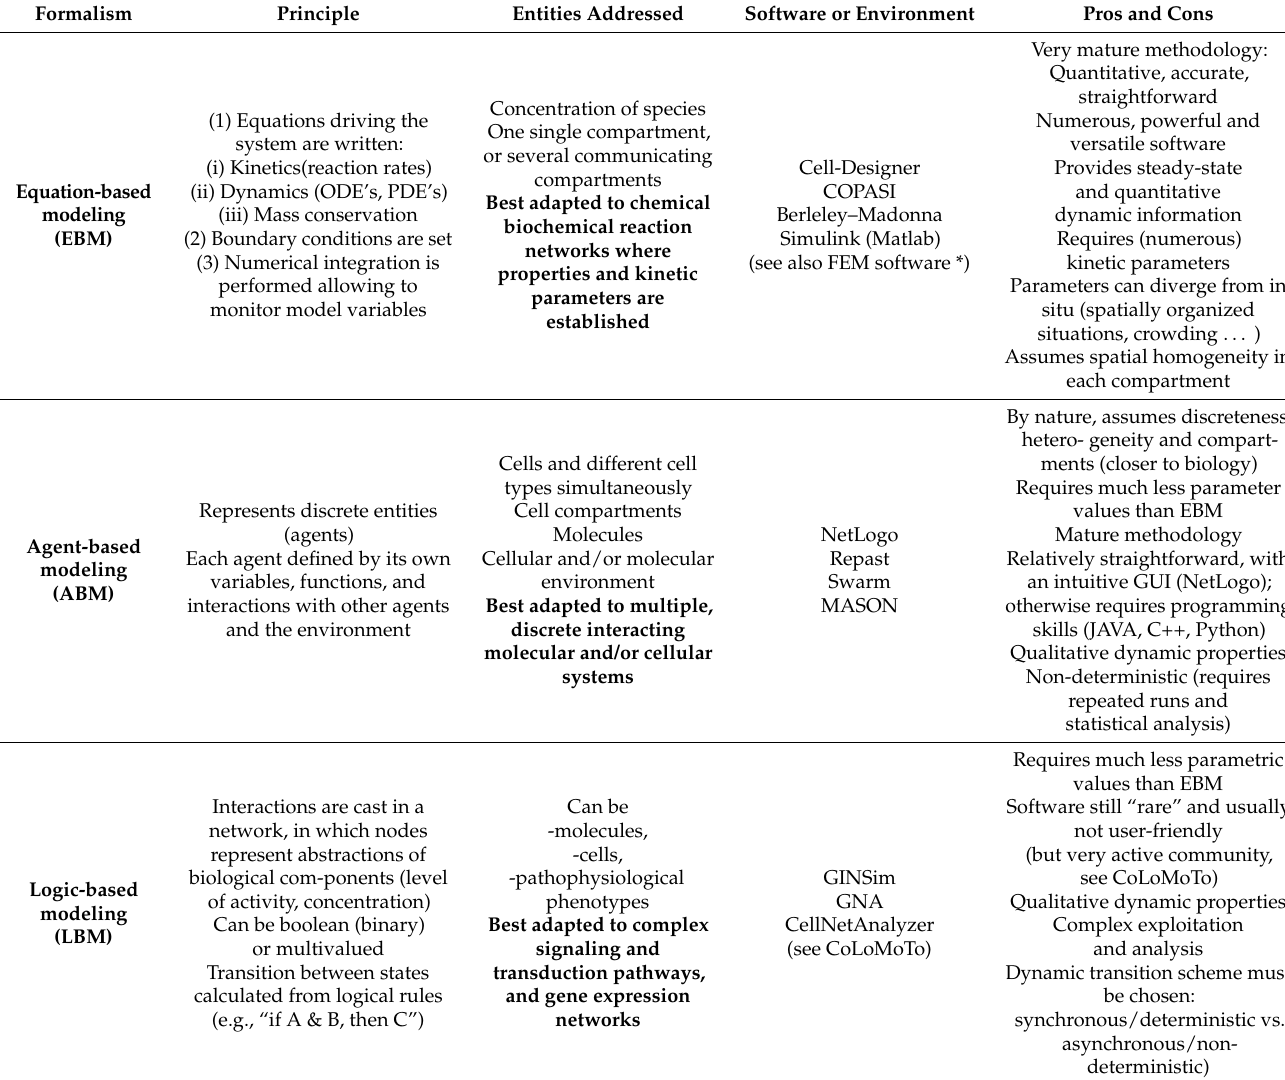
Table 4. Comparative summary of the main MS formalisms and associated